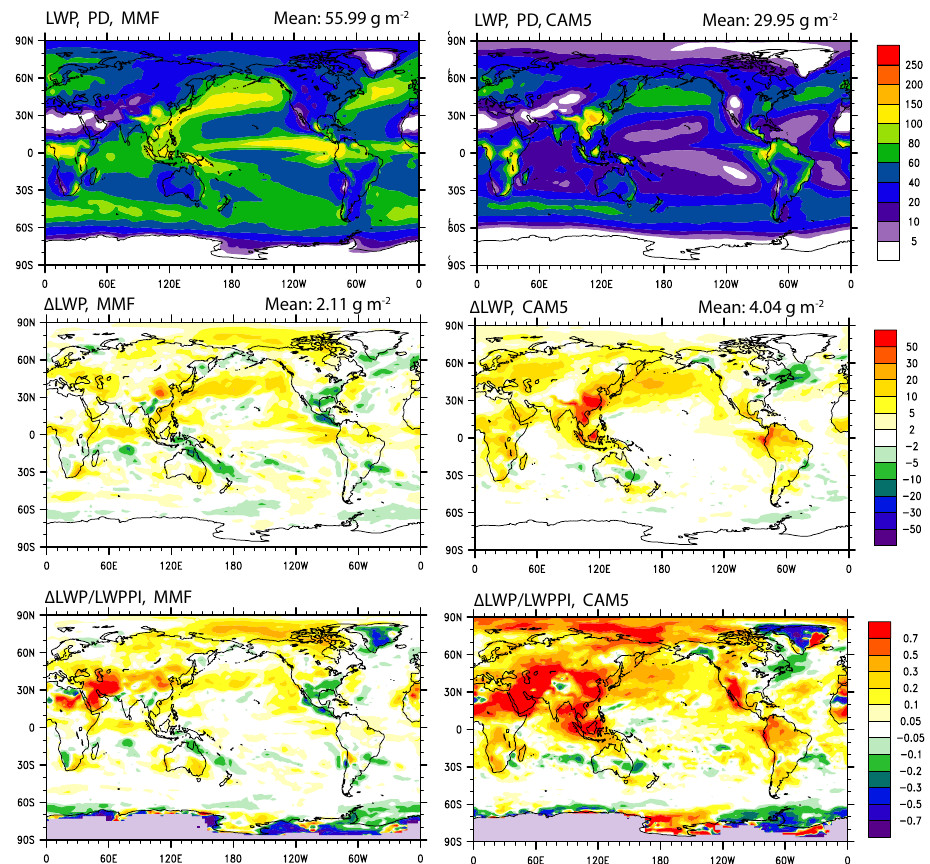
14.∆LWP/LWPPI, Fig. 14. Annual-averaged global distribution of liquid water path (LWP) in the PD simulations (top panels), the difference between PD and Figure PI (PD–PI) (middle panels), and the relative differences between PD and PI [(PD–PI)/PI] (bottom panels) in both the MMF (left panels) and CAM5 (right panels). Liquid water path in CAM5 is from large-scale clouds only and does not include contributions from convective